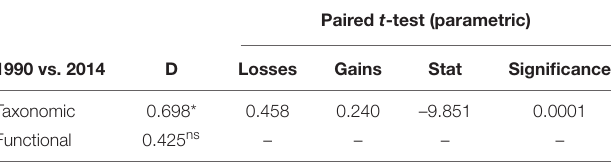
TABLE 4 | TBI results for taxonomic and functional temporal beta diversity differences and results of the paired t -test of significance of the processes (losses or gains) dominated and caused taxa composition changes between 1990 and